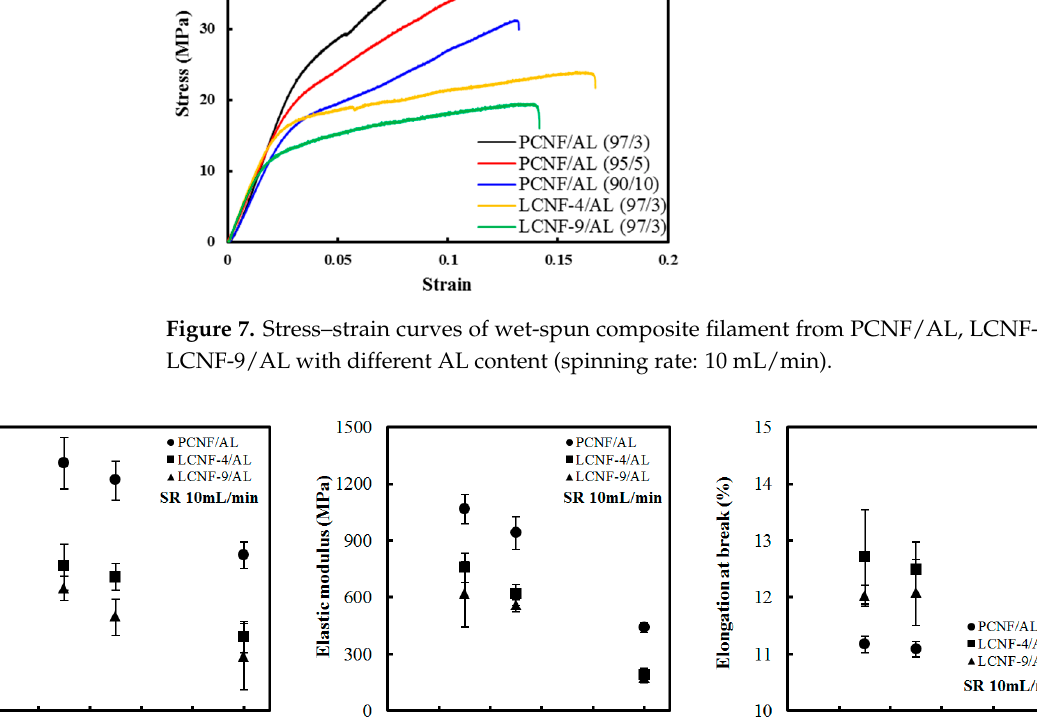
Figure 9. Tensile strength, elastic modulus, and elongation at break of wet-spun composite filaments from PCNF/AL, LCNF-4/AL, and LCNF-9/AL with a CNF/AL ratio of 97/3 at different spinning rates.